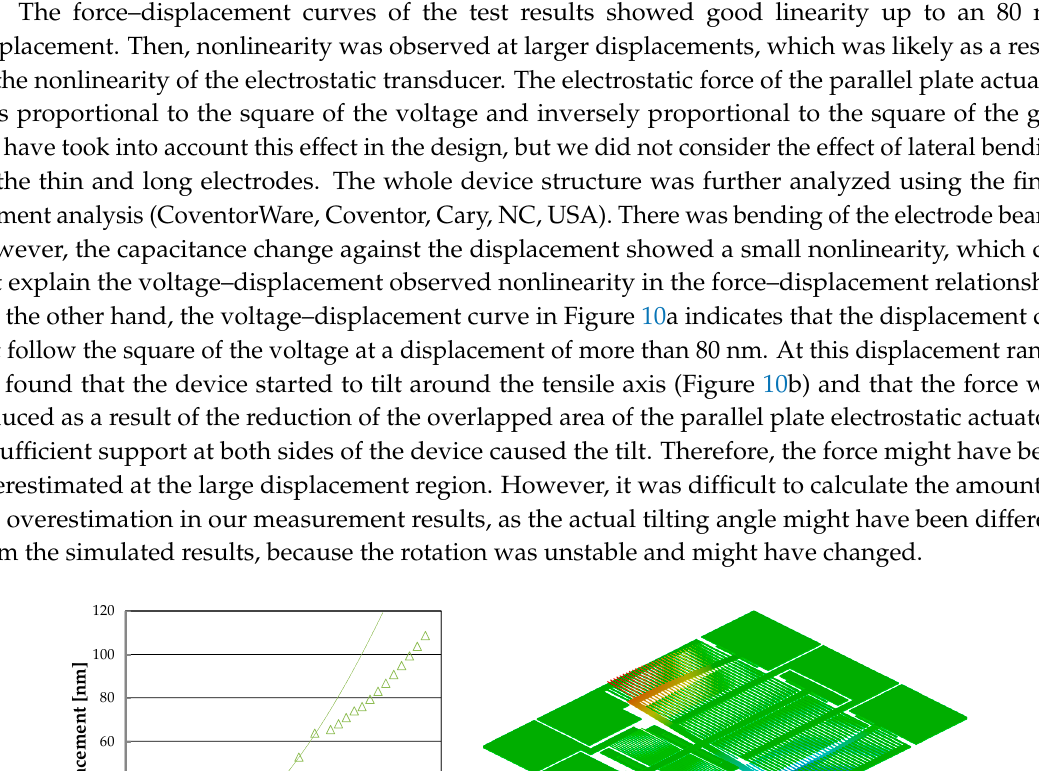
Figure 11. Enlarged view of specimen A before tensile testing.